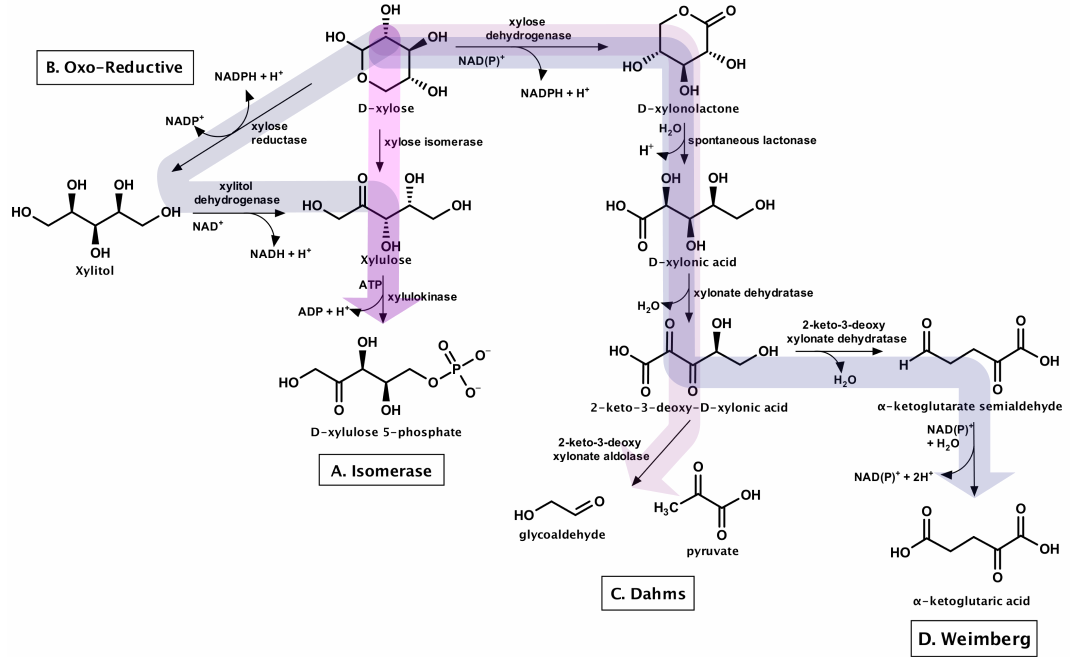
Figure 3. Xylose catabolic pathways. Both the ( A ) isomerase and ( B ) oxo-reductive pathways produce xylulose for the pentose phosphate pathway, while the ( C ) Dahms and ( D ) Weimberg pathways yield the central carbon metabolites, glycoaldehyde and pyruvate, and α -ketoglutaric acid for the Tricarboxylic Acid Cycle (TCA) cycle,